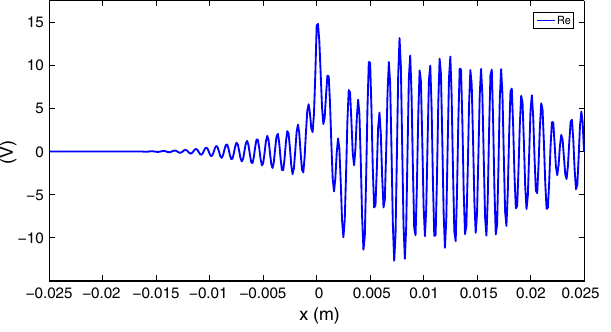
ˆ H k; s; x Þ at y ¼ g , at the xp ð